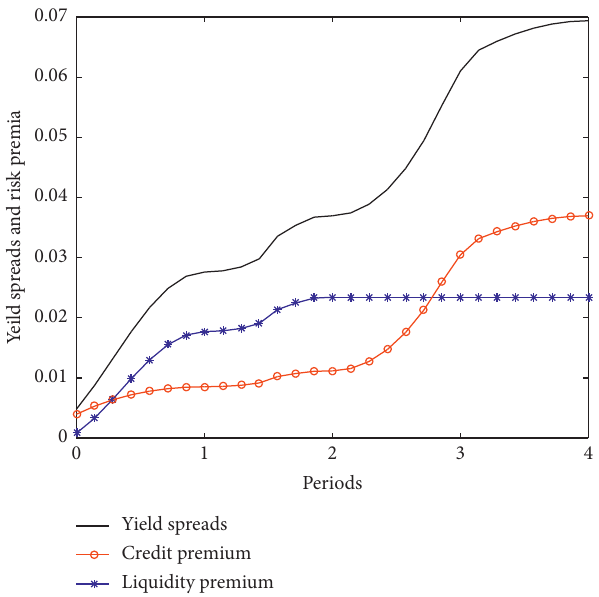
Figure 3: Yield spreads and risk premium in credit-leading